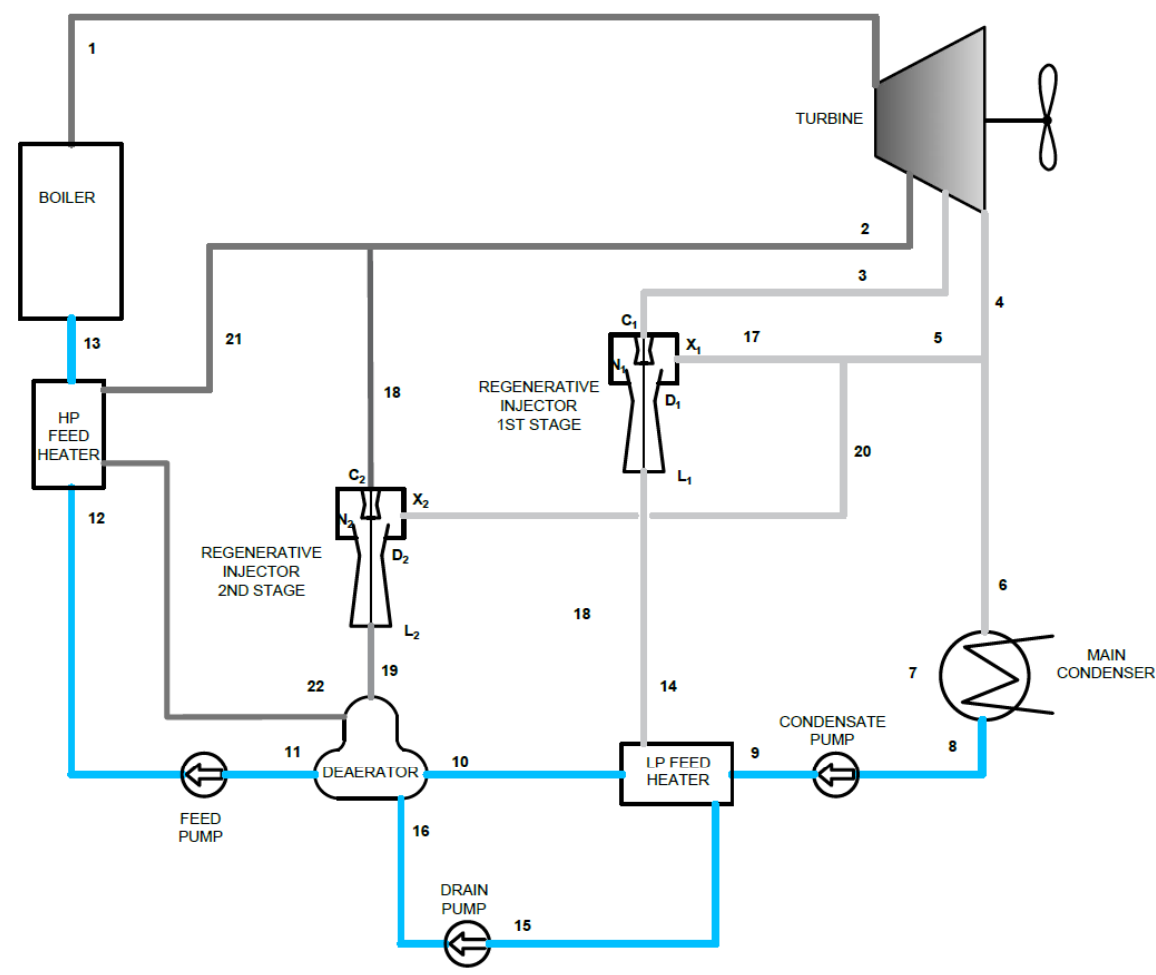
Figure 9. Thermal flow diagram of the regenerative cycle with single-stage regenerative injectors. Table 4. Thermodynamic parameters of the working fluid in the control planes of the regenerative cycle with single-stage injectors.